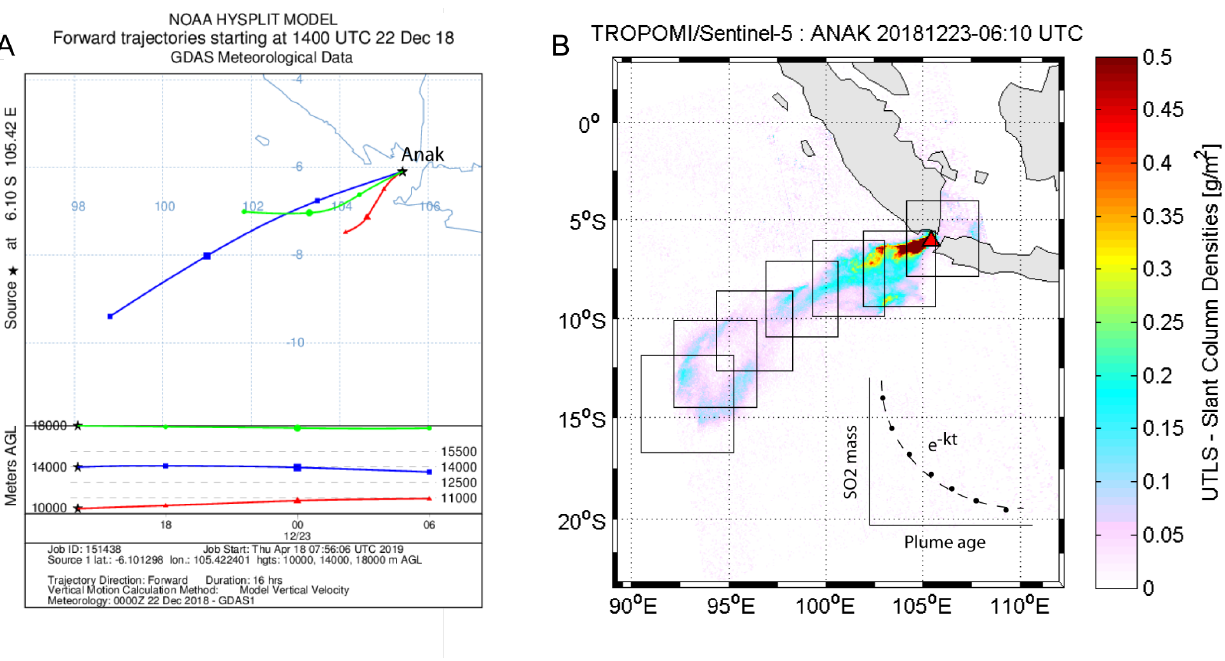
Figure 1: SO mass fluxes retrieval. [A] Run example of HYSPLIT forward trajectory on 22/12/2018 at 14:00UTC 2 showing the best trajectory (blue line) drifting in the south-westward direction at an altitude of 14 km AGL with an average velocity of 15m/s. [B] Tropomi/Sentinel-5 image on 23/12/2018 showing the SO densities (g/m 2 ) at UTLS level (Upper Troposphere Lower Stratosphere). Also, the boxes used for the assessment of e-folding time correction are